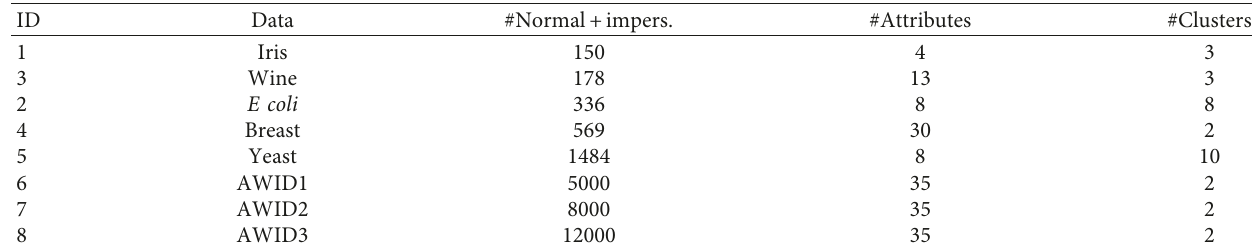
Table 1: Main characteristics for clustering evaluation.